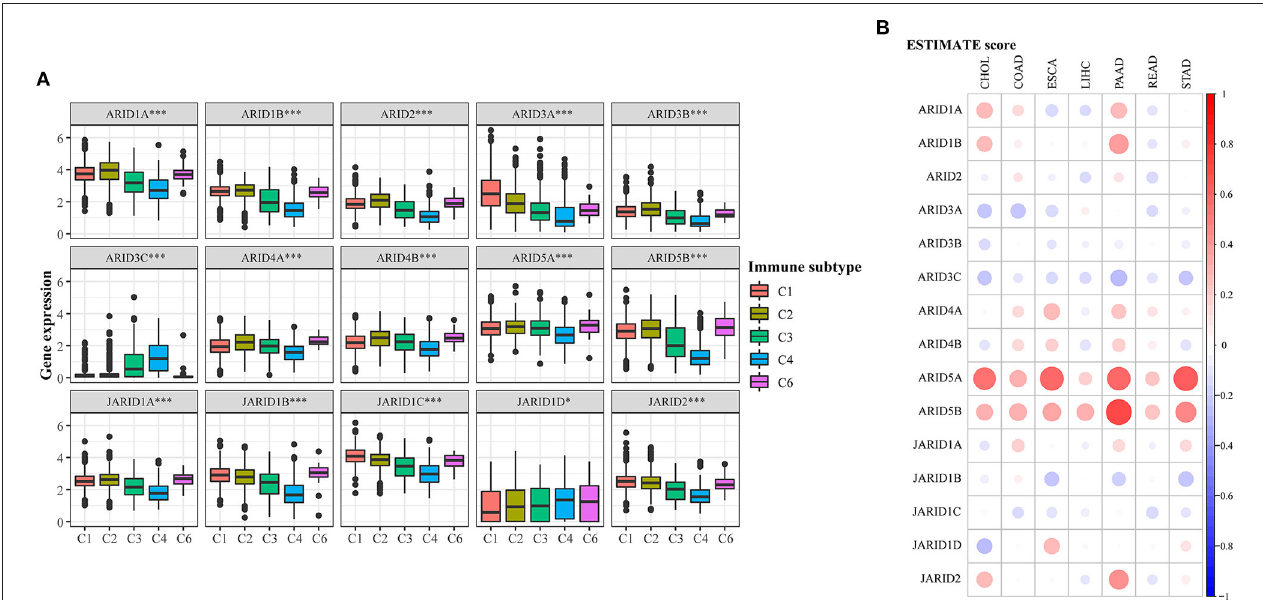
FIGURE 3 | Association of ARIDs expressions with tumour microenvironment factors. (A) Association of ARIDs expression with immune infiltrate subtypes across digestive cancer types. * P < 0.05, ** P < 0.01, *** P < 0.001. (B) Correlations between ARIDs expressions and ESTIMATE scores of digestive cancer. Bigger dot stands for higher correlation